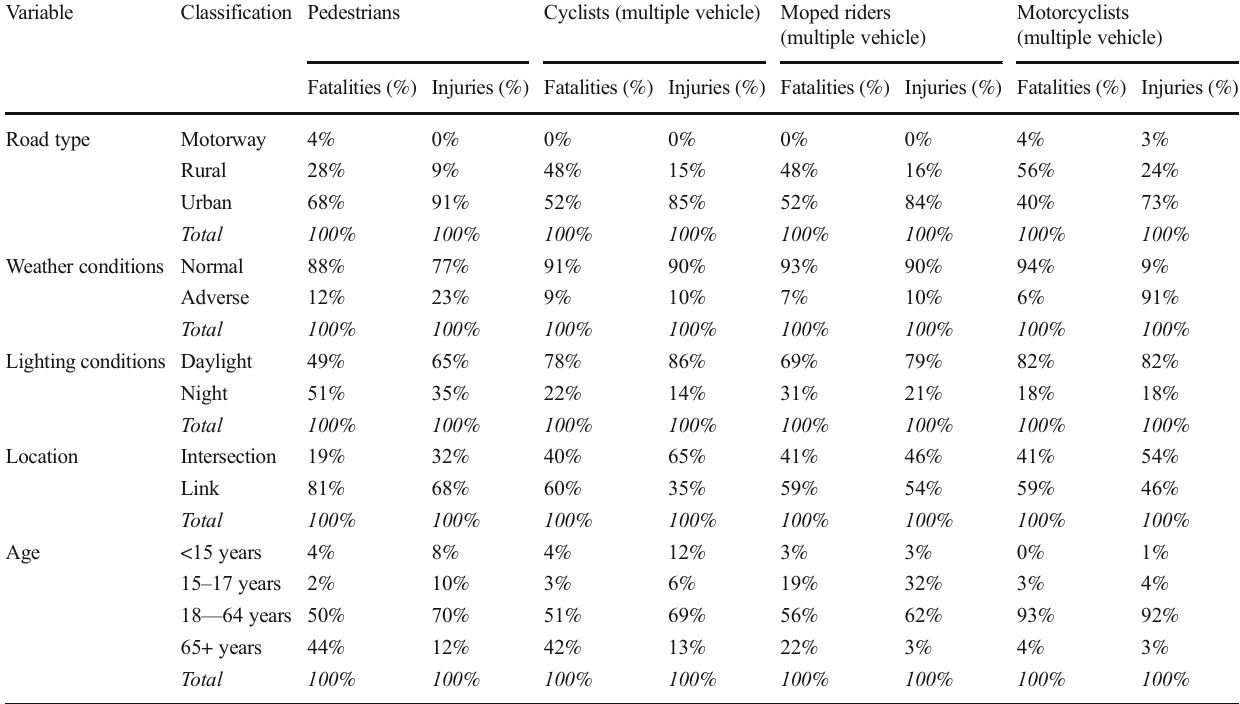
Distribution of vulnerable road user fatalities and injuries by variable including the classification of each variable Variable Classification Pedestrians Cyclists (multiple vehicle) Moped riders